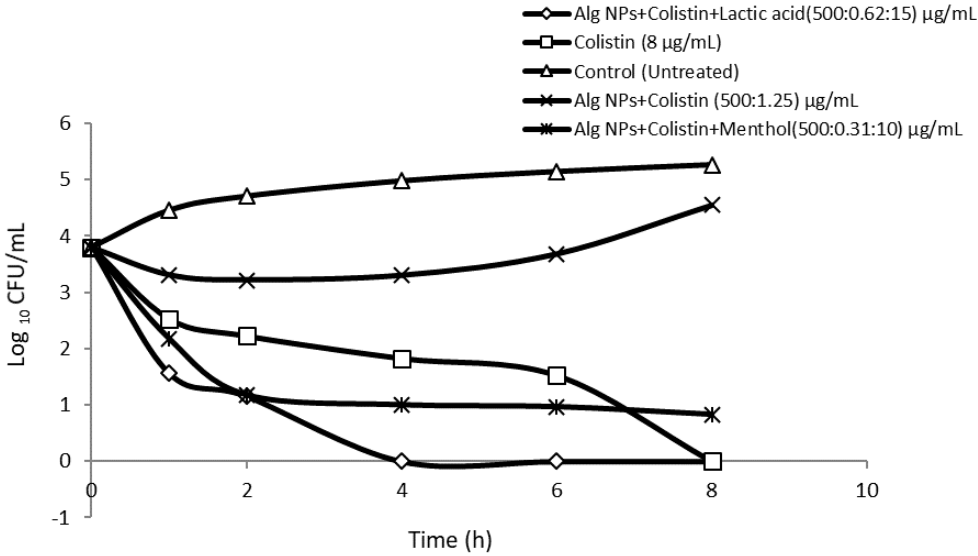
Figure 2. Killing curves of Escherichia coli 184 treated with different formulations of colistin associated with Alg NPs and menthol or lactic acid.